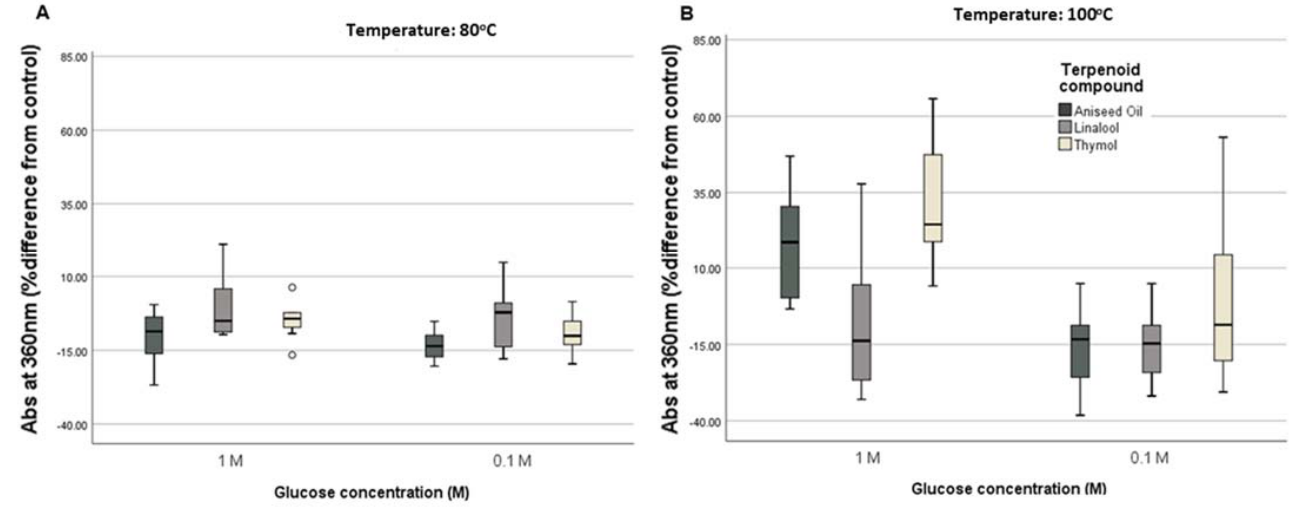
Figure 4. The effect of terpenoid compounds on intermediate glycation products formation (360 nm) in heated glucose/lysine solutions at 0.1 M and 1 M glucose at pH 7.2 and ( A ) 80 °C and ( B ) 100 °C. Symbols (*,**, °) outside the boxplots indicate outliers.